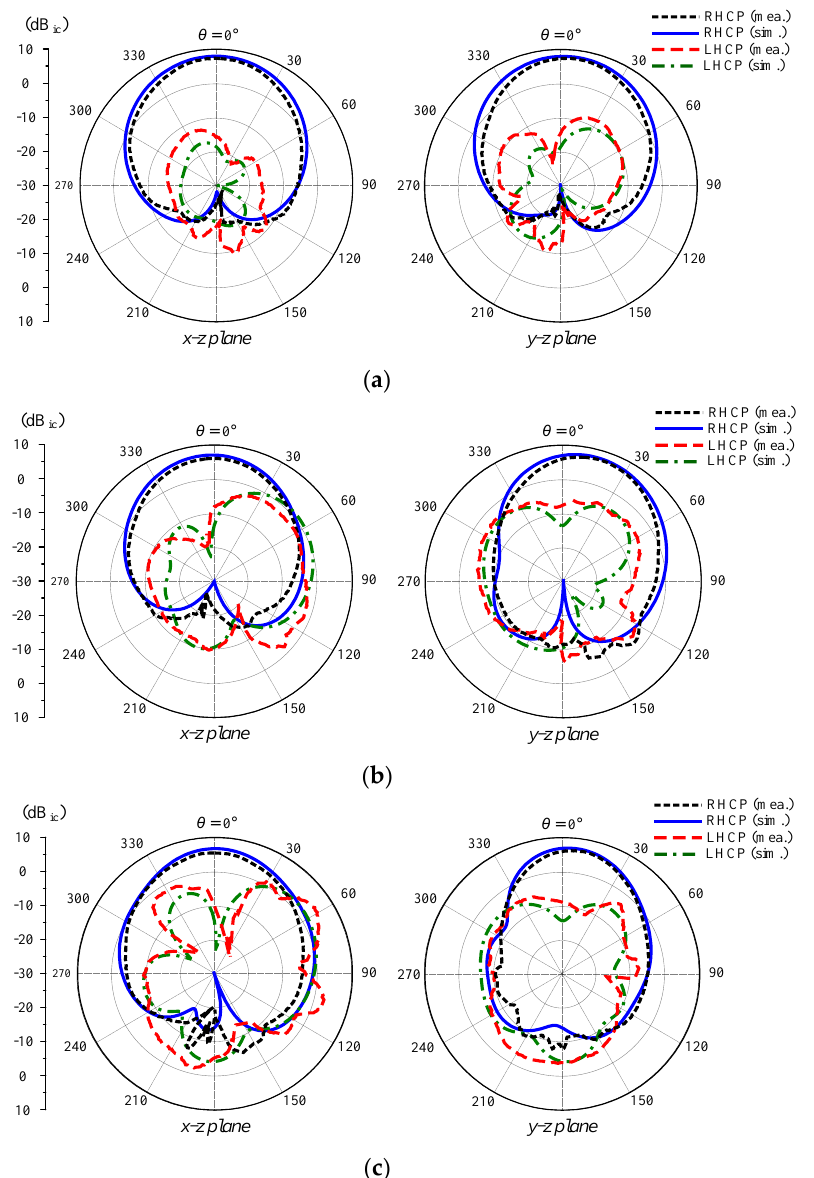
Figure 10. Simulated and measured AR and broadside gain of the proposed antenna.